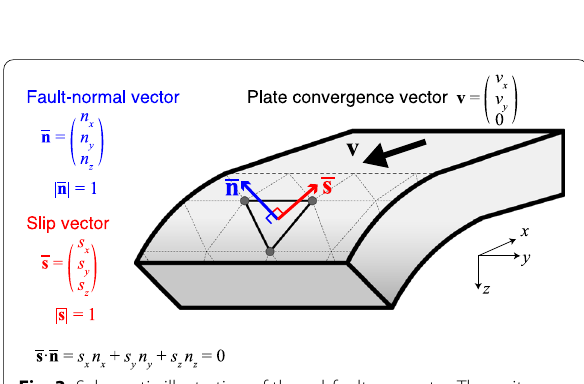
Fig. 3 Schematic illustration of the subfault geometry. The unit fault-normal vector n (blue arrow) is derived from the locations of the subfault vertices (gray dots). The unit slip vector s (red arrow) is derived from the plate convergence vector v (thick black arrow) and the dot product of the fault-normal and the slip vectors ( s • n = 0